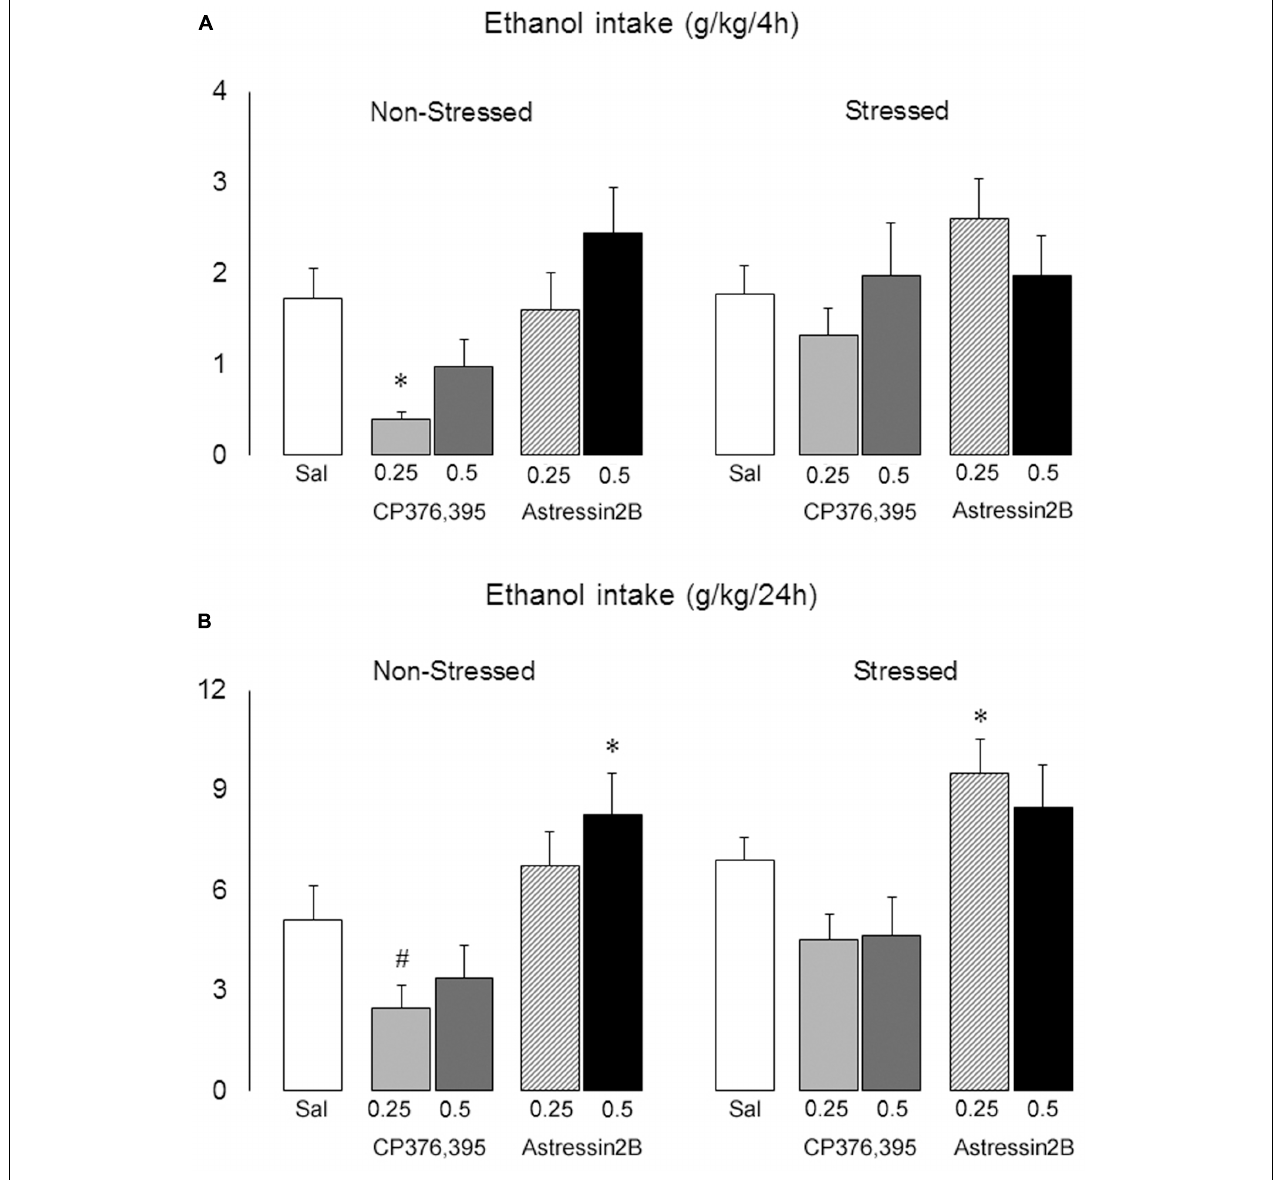
FIGURE 9 | Effects of intra-BNST CRFR1 (CP376,395, CP) or CRFR2 (Astressin2B, A2B) antagonists on ethanol consumption in non-stressed controls and socially defeated mice exposed to continuous access to ethanol/water for 4 weeks. After infusions, mice were given continuous access to ethanol and water for 2 h, (A) 4 h and (B) 24 h. The graphs are split into non-stressed and stressed groups. Left bars represent non-stressed mice. Right bars represent socially defeated mice. Left, groups from left to right: Sal, non-stressed controls + saline, n = 20; 0.25, non-stressed controls + CP 0.25 µ g/side, n = 11; 0.5, non-stressed controls + CP 0.5 µ g/side, n = 11; 0.25, non-stressed controls + A2B 0.25 µ g/side, n = 9; 0.5, non-stressed controls + A2B 0.5 µ g/side, n = 9. Right, groups from left to right: Sal, stressed mice + saline, n = 24; 0.25, stressed mice + CP 0.25 µ g/side, n = 12; 0.5, stressed mice + CP 0.5 µ g/side, n = 11; 0.25, stressed mice + A2B 0.25 µ g/side, n = 12; 0.5, stressed mice + A2B 0.5 µ g/side, n = 12. Data are mean ± SEM. ∗ versus Sal group in the same condition (Non-stressed or Stressed, p < 0.05); # versus Non-stressed + Sal group ( p =